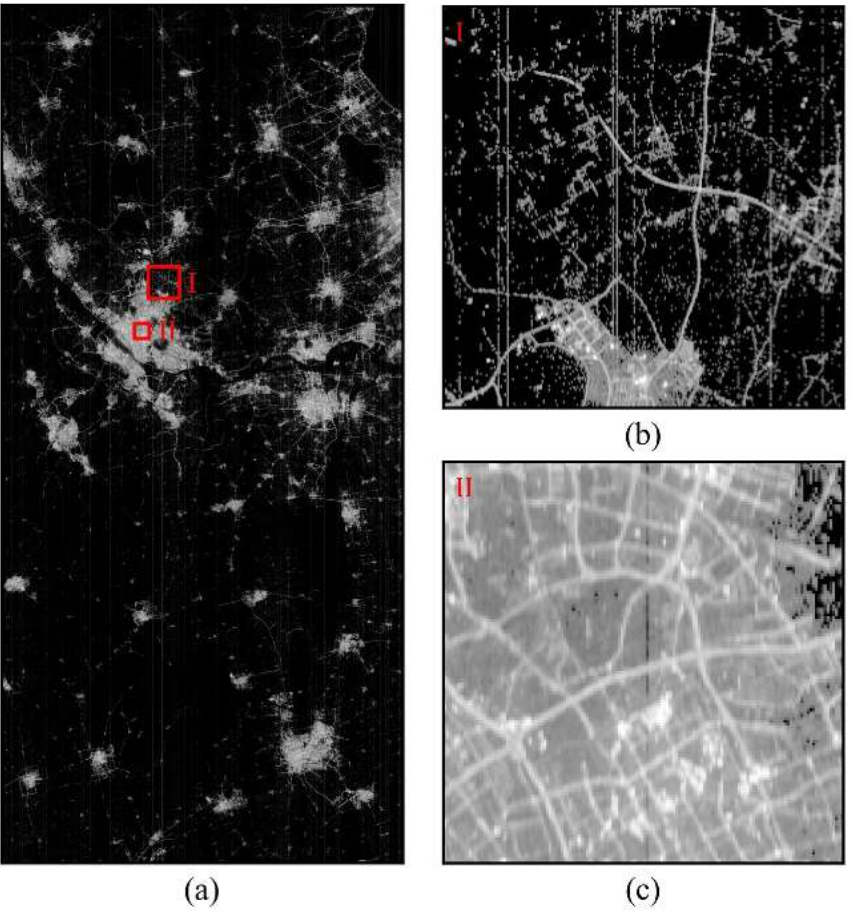
Figure 3. Different types of stripes in GI images (B1 Band). ( a ) Full-size image; ( b ) bright stripes; ( c ) dark stripes. (1) The bright stripe